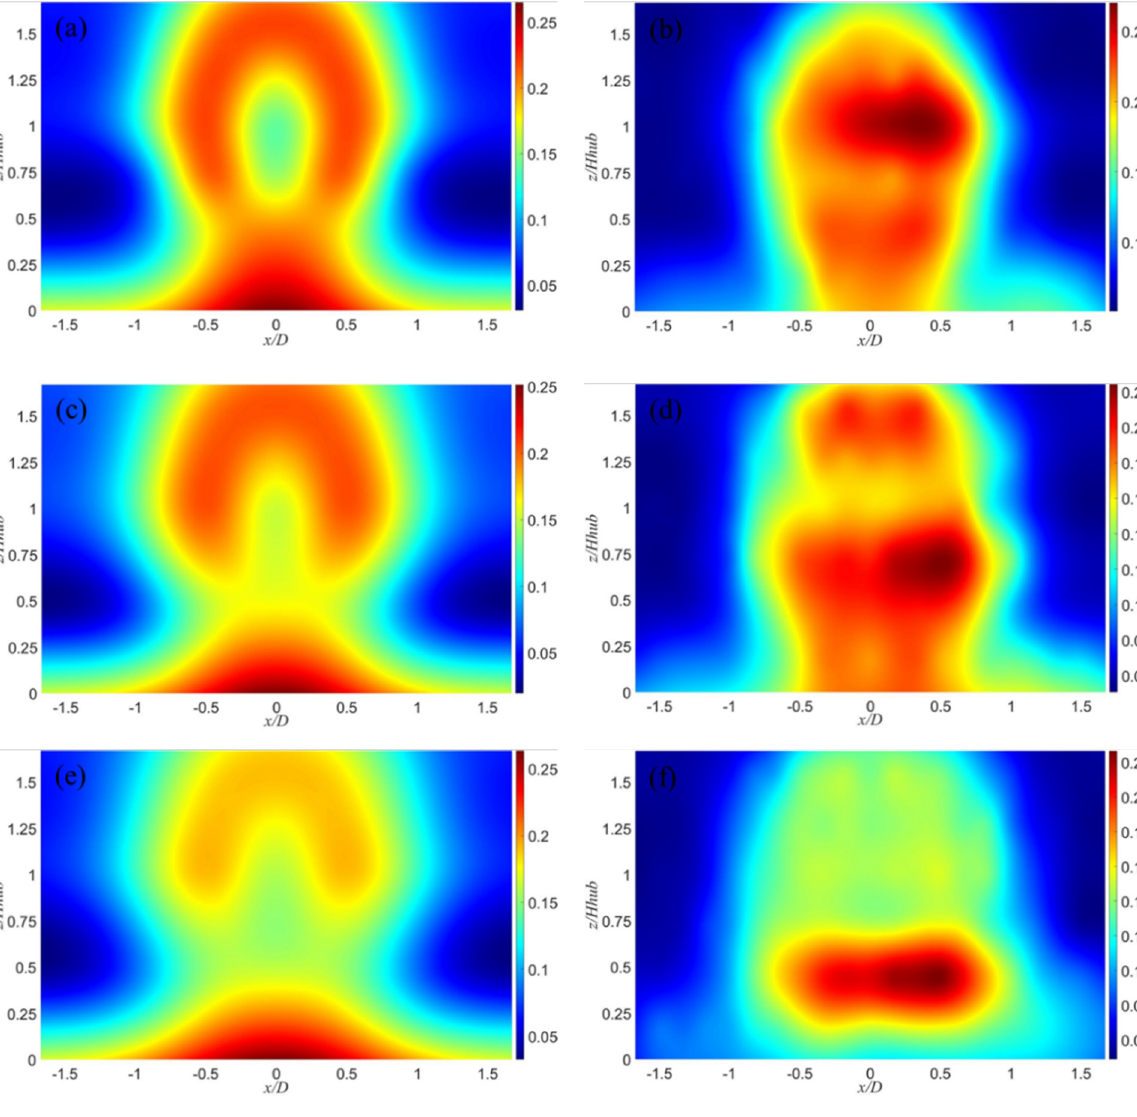
Figure 9. Contours of turbulence intensity of the Gaussian wake model and the thrust-optimized model for U06-Iu06- γ 00 - Opt case. ( a ), ( c ), and ( e ) are Gaussian wake model at x / D = 4, 5, and 6, respectively; ( b ), ( d ), and ( f ) are thrust-optimized model at x / D = 4, 5, and 6, respectively.